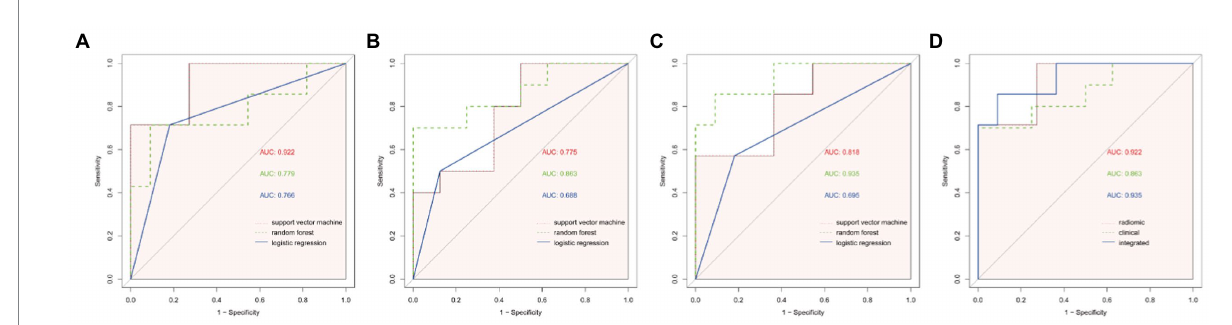
FIGURE 5 ROC curves of different models. (A) The ROC curves of the three modelling approaches of support vector machine (svm), random forest (rf) and logistic regression (logit) for the radiomic model, and the AUC of the svm model was found to be significantly different from that of the logistic regression model by Delong test ( p = 0.027). (B) ROC curves for the three modelling approaches of svm, rf and logit for clinical models, and no statistical significance was found between the three by Delong test ( p > 0.05). (C) ROC curves for the three modelling approaches of ssvm, rf and logit for integrated model, with a significant difference in AUC between the rf model and logit model found by Delong test ( p = 0.047). (D) ROC curves for the best modelling approach for the three models. Combining the results of the AUC and the Delong test, the svm model was chosen for the radiomic model, the rf was chosen for the clinical model and the rf was chosen for the integrated model, and finally the Delong test revealed no statistical significance between the three modelling approaches ( p > 0.05).